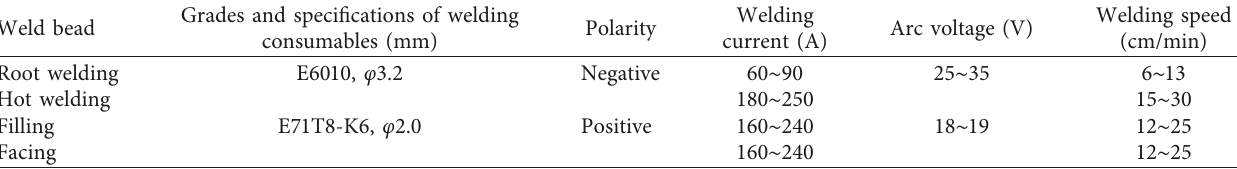
Table 2: Welding parameters.